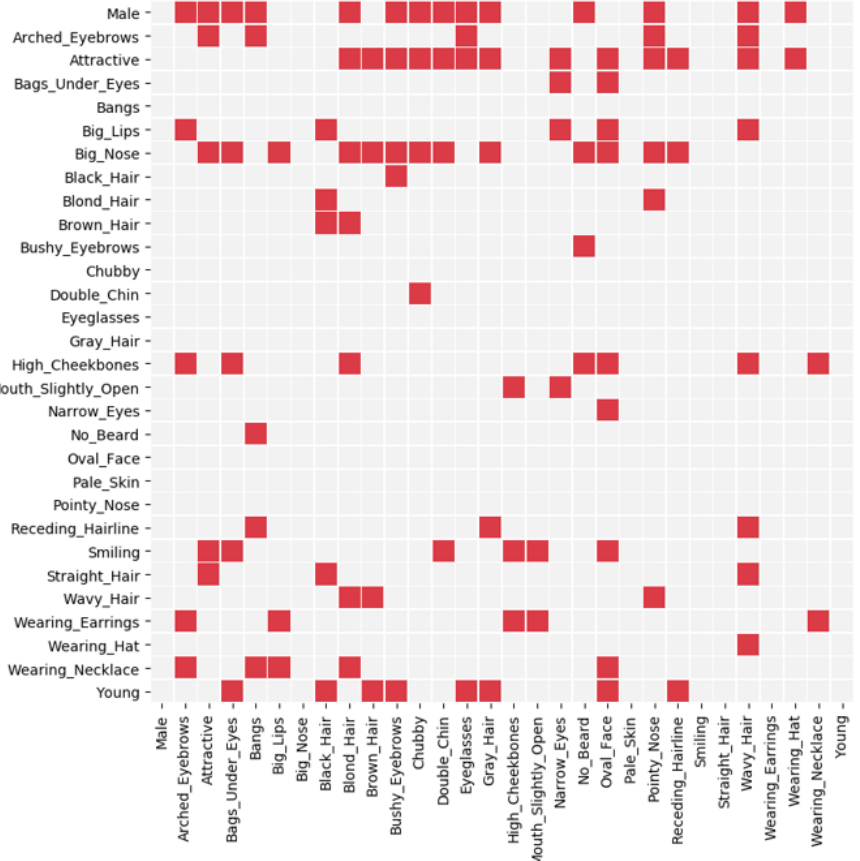
Figure 2. The discovered causal structure among the y and A . The red and gray rectangles denote the existence and absence of cause and effect,